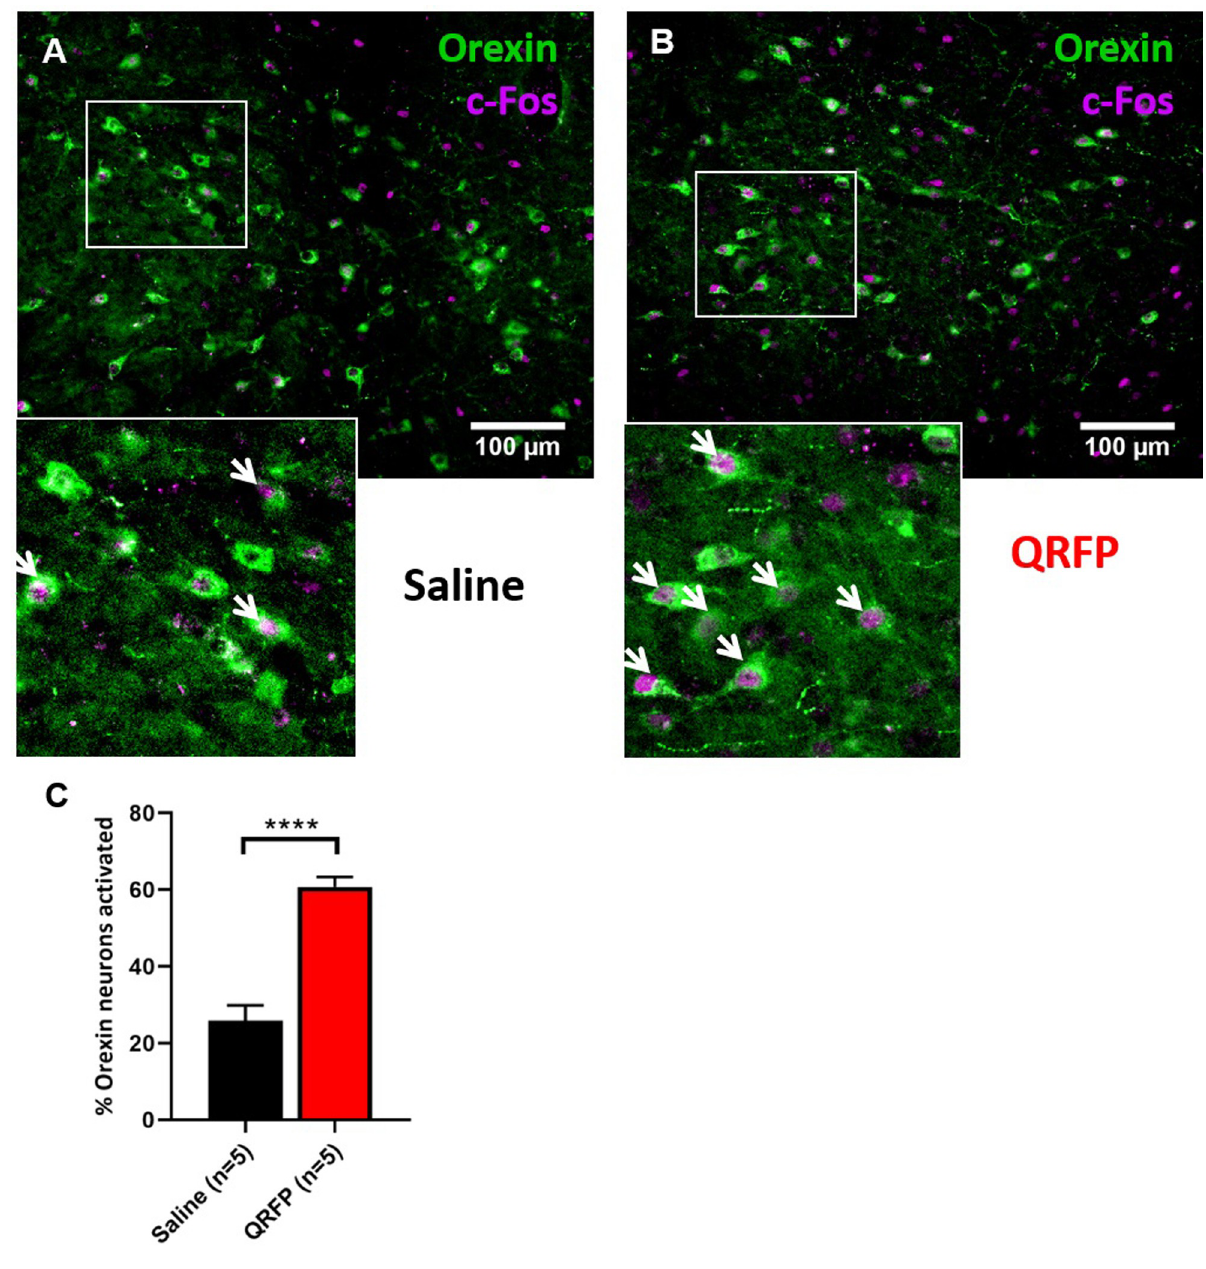
Fig 5. ICV QRFP caused an activation of orexin/hypocretin neurons. Dual-label immunohistochemistry for FOS (magenta) and orexin/hypocretin (green) in the lateral hypothalamus after ICV injection of either (A) saline or (B) QRFP. (C) Orexin/hypocretin neurons are activated by QRFP (t 8 = 7.36). Student’s t-Test. ���� p < 0.0001. 3–4 sections per mouse were analysed at approximately -1.8 mm relative to